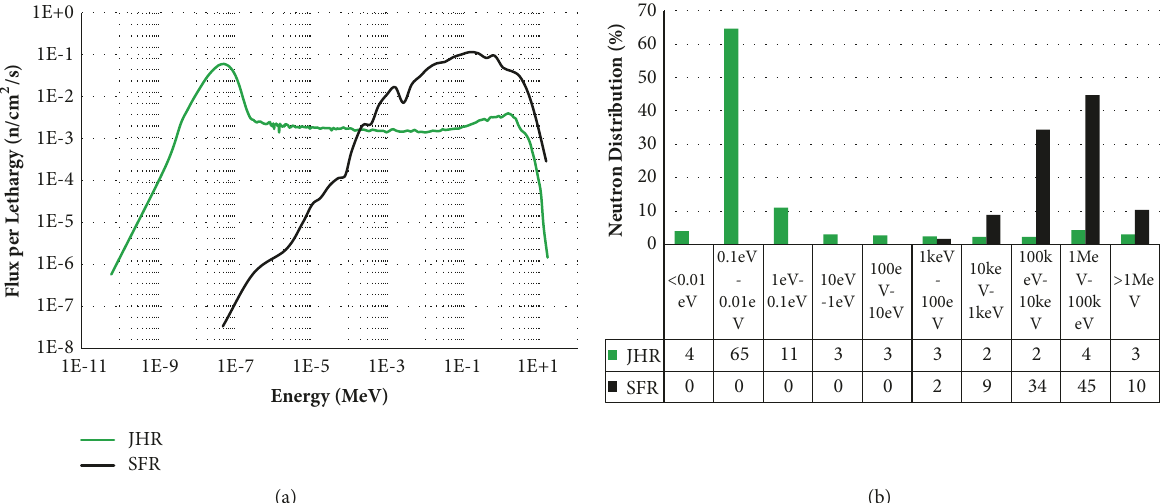
Figure 5: Comparison of the two reference spectra, assuming void in the irradiation facility; (a) neutron flux normalized to lethargy in JHR reflector (green line) and SFR (black line) and (b) neutron distribution per energy group (in %) for SFR (black) and JHR reflector